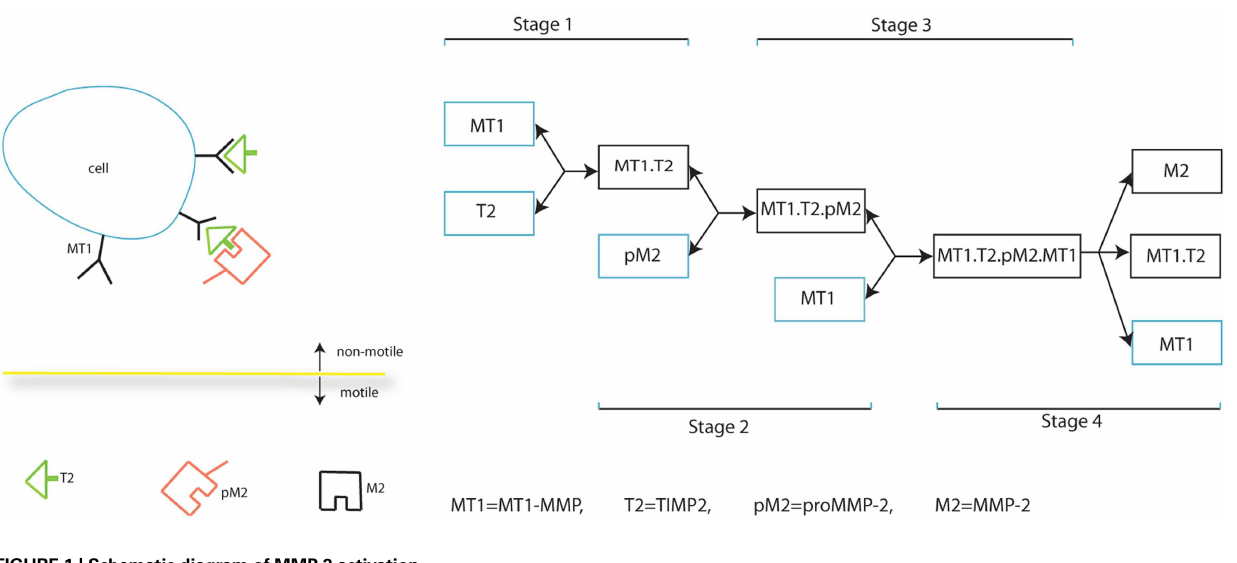
FIGURE 1 | Schematic diagram of MMP-2 activation.